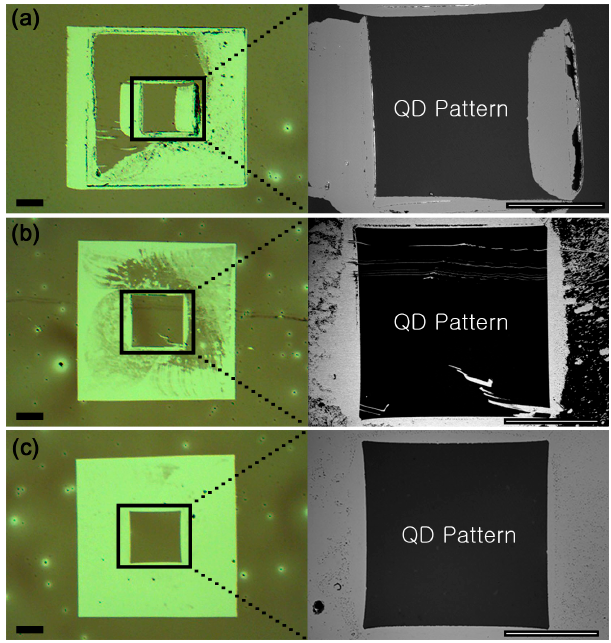
Figure 2. Optical images of the patterned QD films and zoomed in SEM images of the boxed region for different experimental conditions. ( a ) The contacting and separation were both conducted at a temperature below T g . ( b ) Both contact and separation were conducted at an elevated temperature (above T g ). ( c ) The stamp is heated above T g and brought to contact, which is subsequently cooled to room temperature (below T g ) prior to separation. All experiments were conducted at the same preload (~5.5 kPa) and separation rate (~2 µm/s). The scale bars indicate 100 µm.